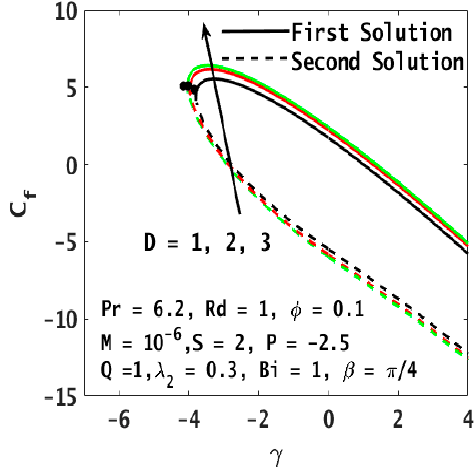
Figure 2. Variation of C (cid:2916) with D .